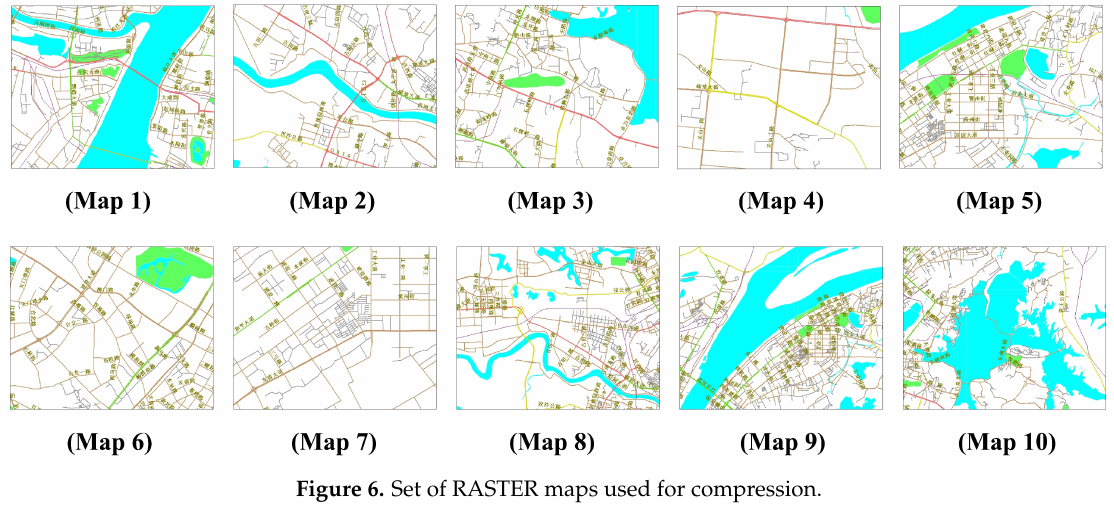
Figure 6. Set of RASTER maps used for compression.